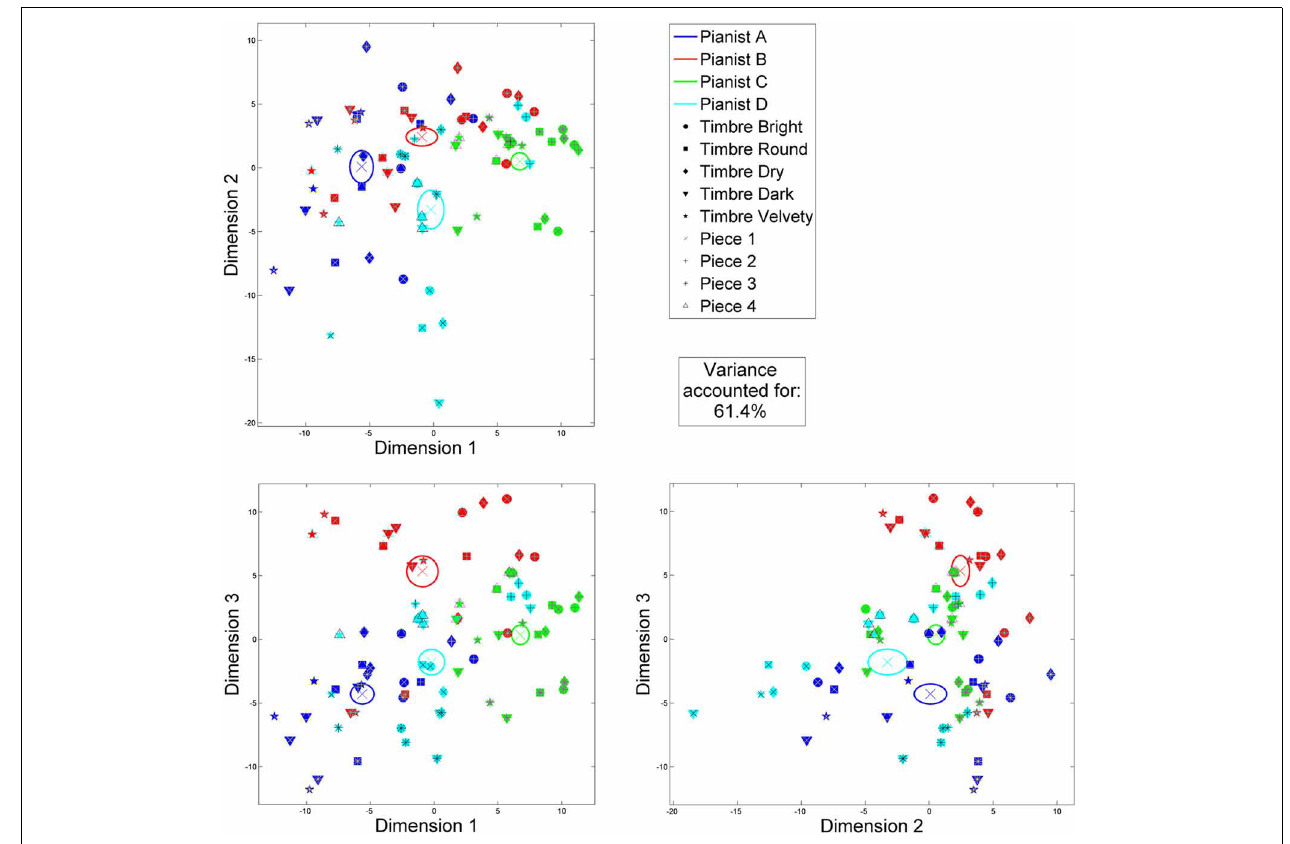
FIGURE 2 | Reduced 3-dimension performance space by PCA and varimax factor rotation applied to 159 significant performance features over the 240-performance dataset: planar projections. For a clearer